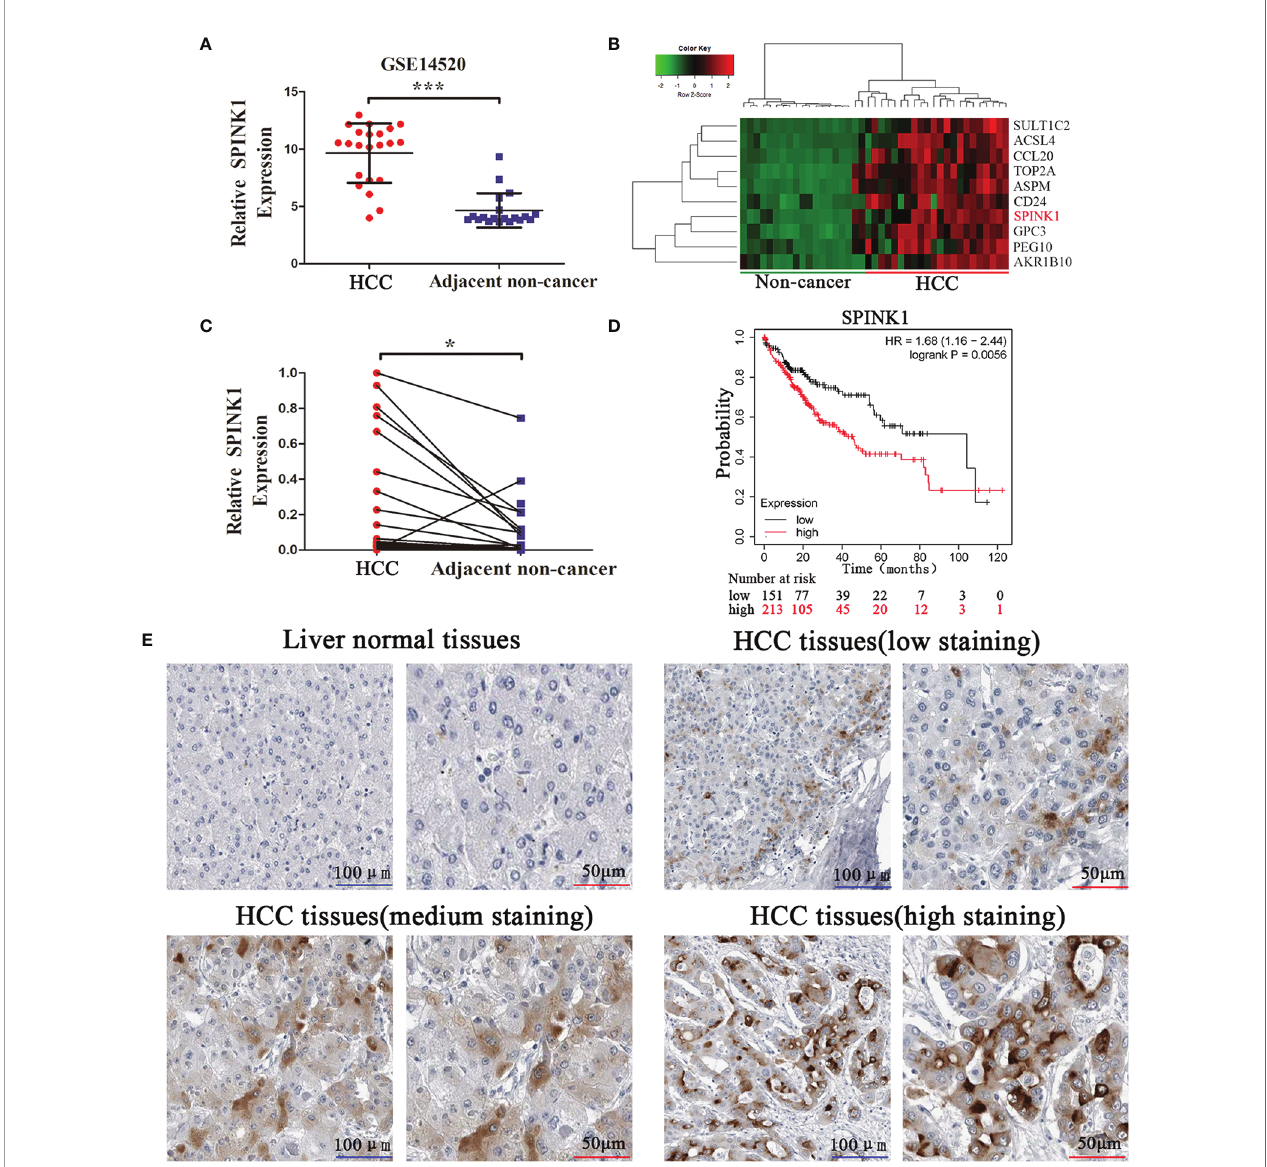
FIGURE 1 | SPINK1 is upregulated in HCC tissues, and high SPINK1 expression is associated with poor prognosis. (A) GEO dataset analysis (GSE14520) reveals that SPINK1 was upregulated in HCC tissues. Data are presented as mean ± SD; statistical signi fi cance was assessed by Student ’ s t-test. *** p < 0.001. (B) The heatmap showed that SPINK1 was primarily clustered in HCC tissues. (C) The results of qRT-PCR reveal that SPINK1 was upregulated in HCC tissues. Data are presented as mean ± SD; statistical signi fi cance was assessed by paired t -test. * p < 0.05. (D) Kaplan-Meier analysis of overall survival from the TCGA dataset reveals that high SPINK1 expression was associated with poor prognosis; the log-rank test was used. p = 0.0056. (E) Immunochemistry (IHC) results from Human Protein Atlas reveal that SPINK1 was upregulated in HCC